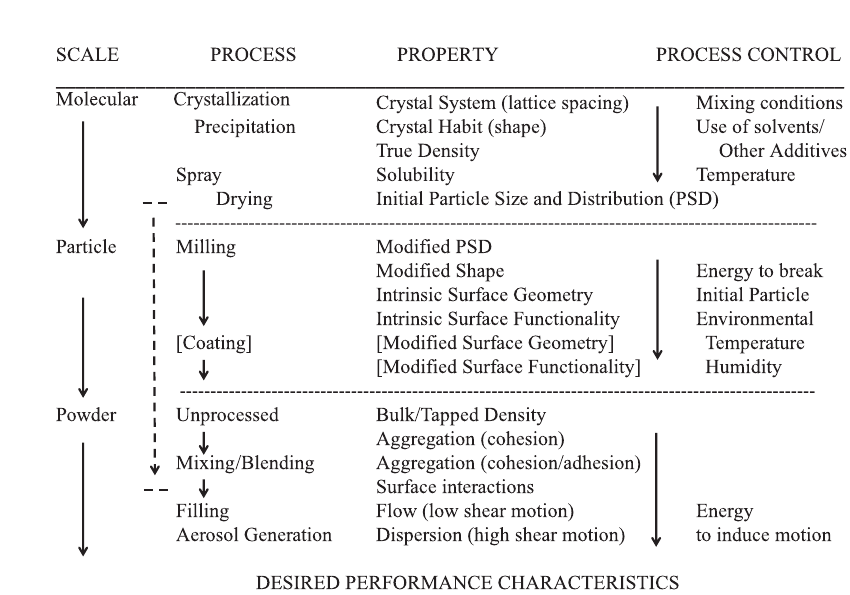
Fig. 9 (a) Arrangement of apparatus to follow light obscuration at the inlet to an inertial impactor; (b) Depiction of the density of particles in air (dictating light obscuration) at three intervals after (top to bottom) initia- tion of aerosol delivery during aerosol delivery; (c) The real-time measurement of obscuration at the de - tector corresponding with (b) , initial, middle and end (top to bottom).